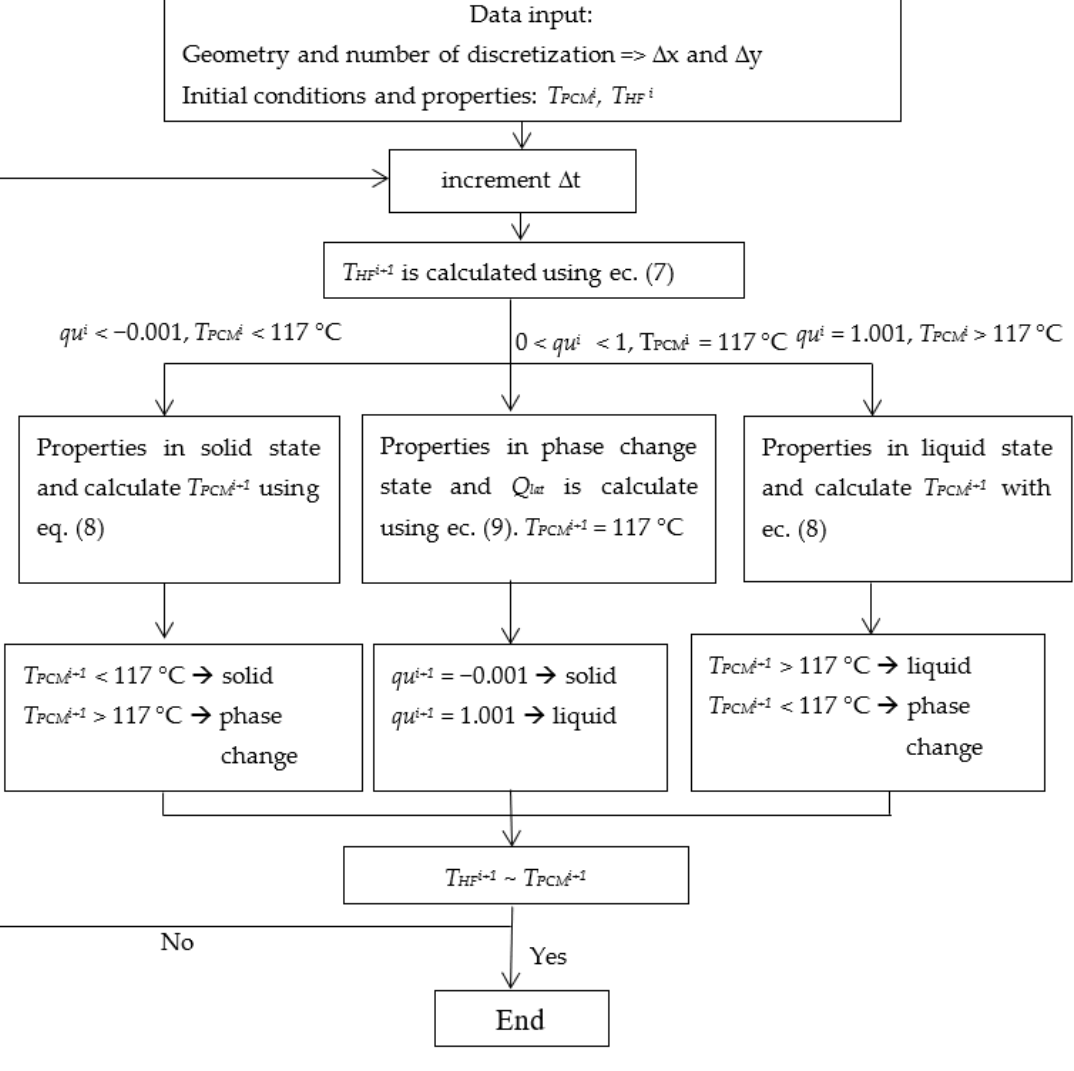
Figure 5. Algorithm for resolution of the mathematical model.